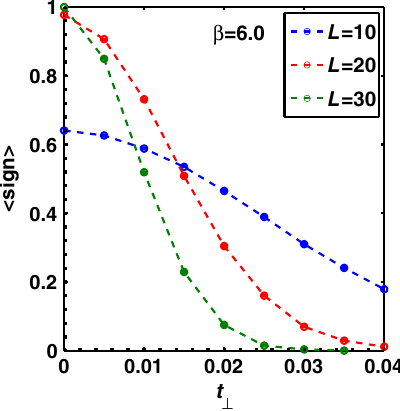
FIG. 9. χ − 1 ð T Þ at t ⊥ ¼ 0 and 0.02, respectively, with the system size L ¼ 20 . Periodical boundary conditions are used. The parameters are V ¼ 0 , J ¼ 2 , n ¼ 1